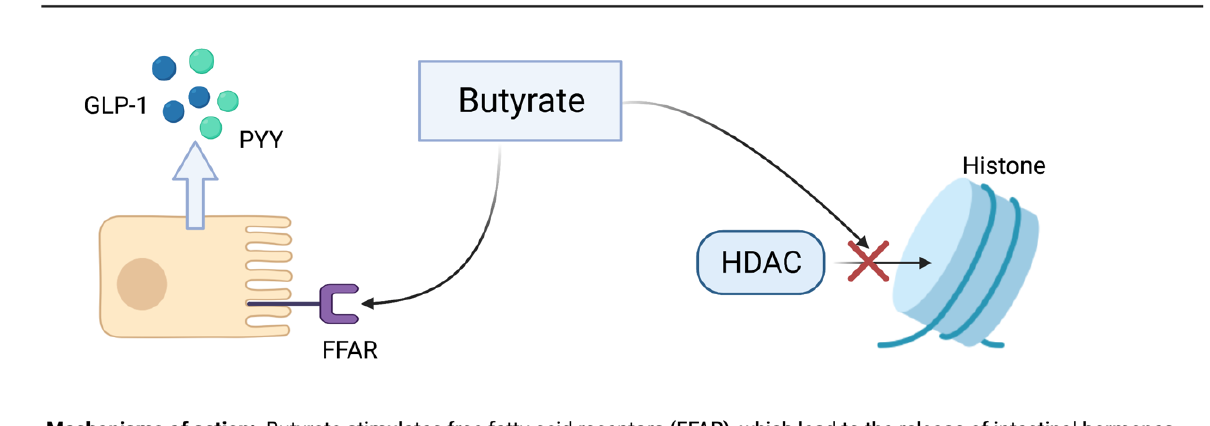
Figure 2. Mechanism of action of butyrate.